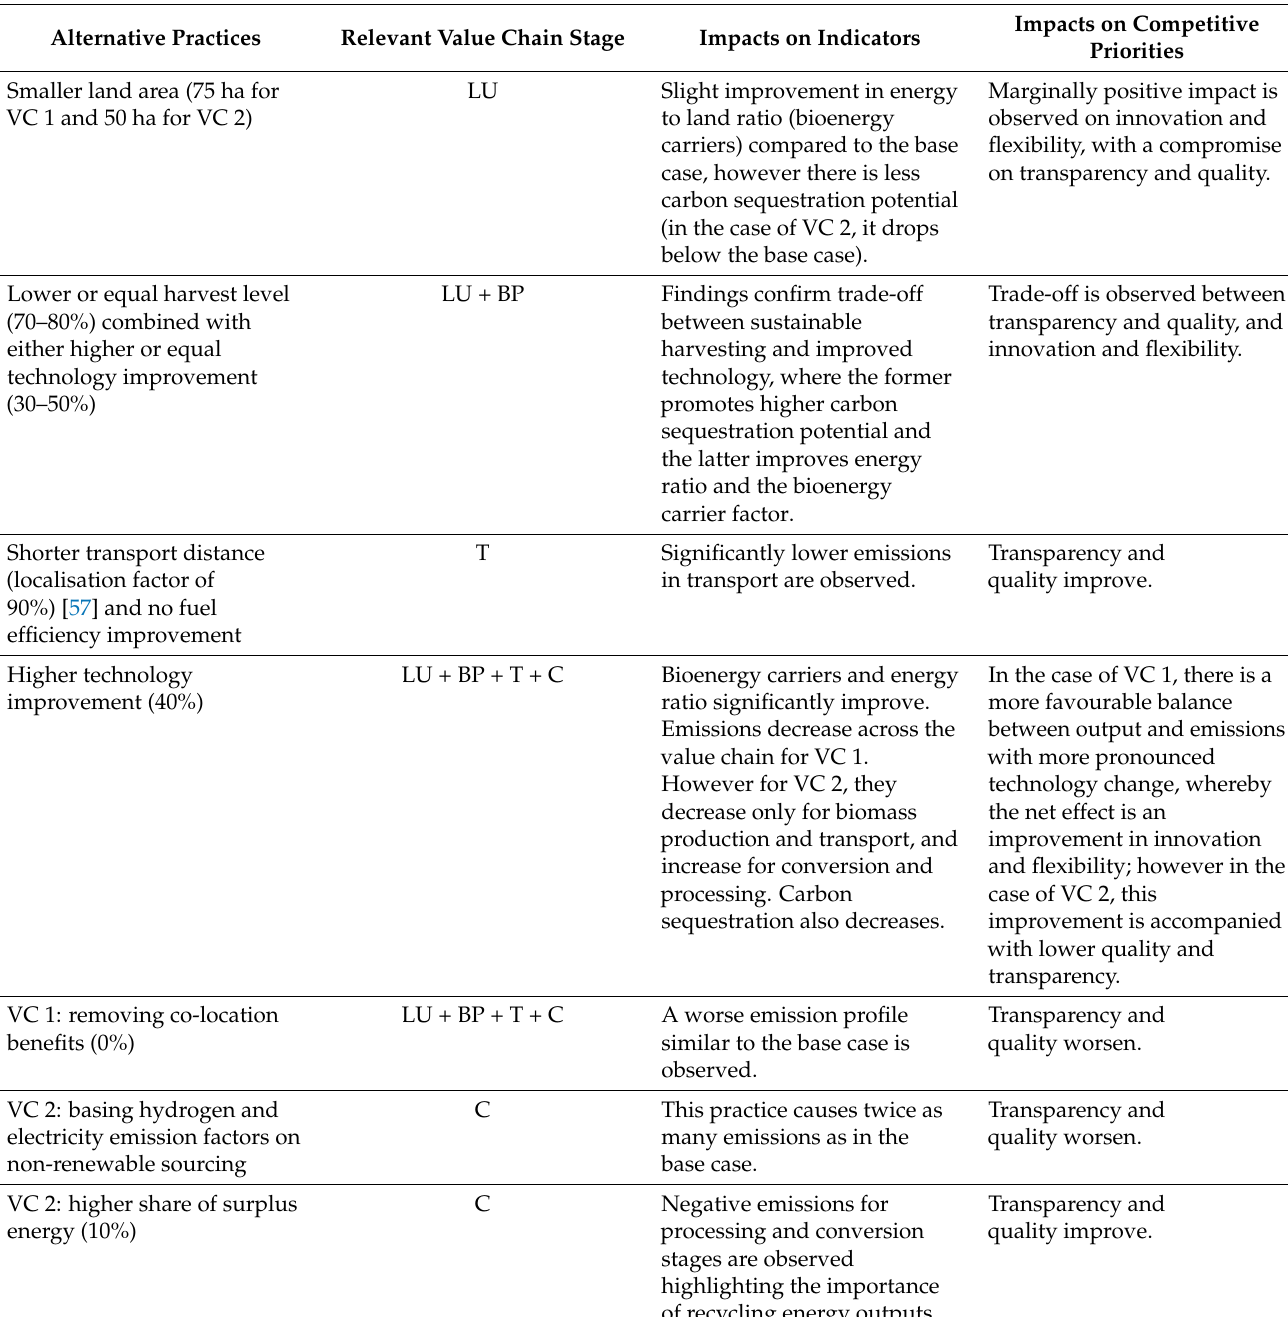
Table 5. Impact of alternative